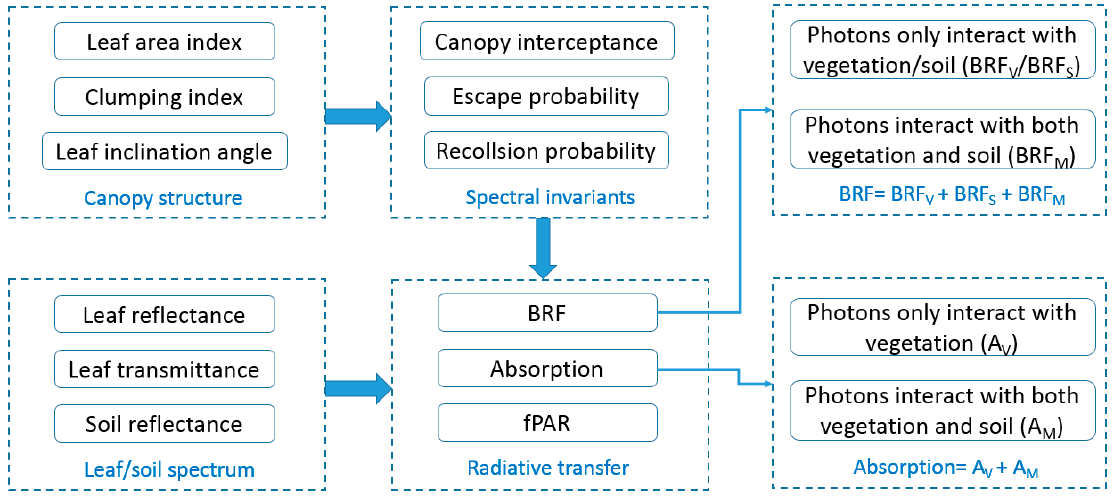
Figure 1. The framework of the spectral invariant properties (SIP) model on how to describe the radiative transfer process from spectral invariants, which are derived bfromcanopy structure parameters. Detailed descriptions of each item are in Section 2.